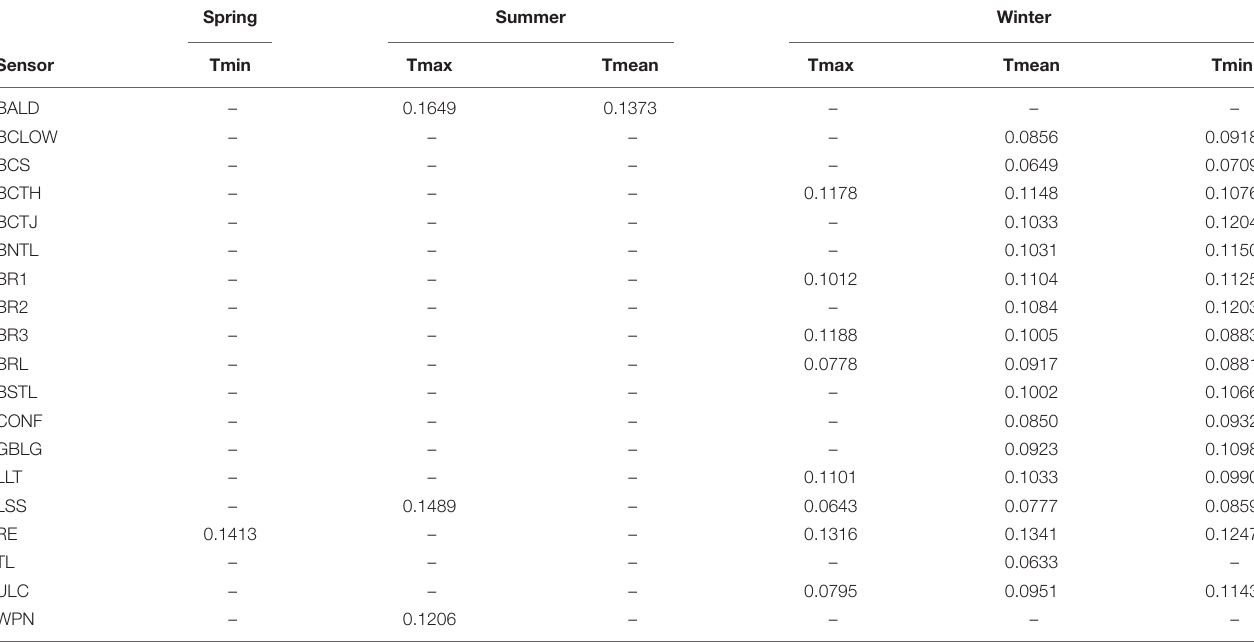
FIGURE 9 | Boxplots illustrating temperature change ( ◦ C) at each sensor over the study period, grouped by elevation, separating trends in: (A) T max ; (B) T mean ; and (C) T min . Group 1 – less than 2500 m, Group 2 – between 2500 and 2999 m, Group 3 – between 3000 and 3249 m, Group 4 – between 3250 and 3499 m, Group 5 – 3500 m and above. All elevations in m. a. s. l. TABLE 4 | Sensors capturing significant seasonal trends in T mean , T min , and T max